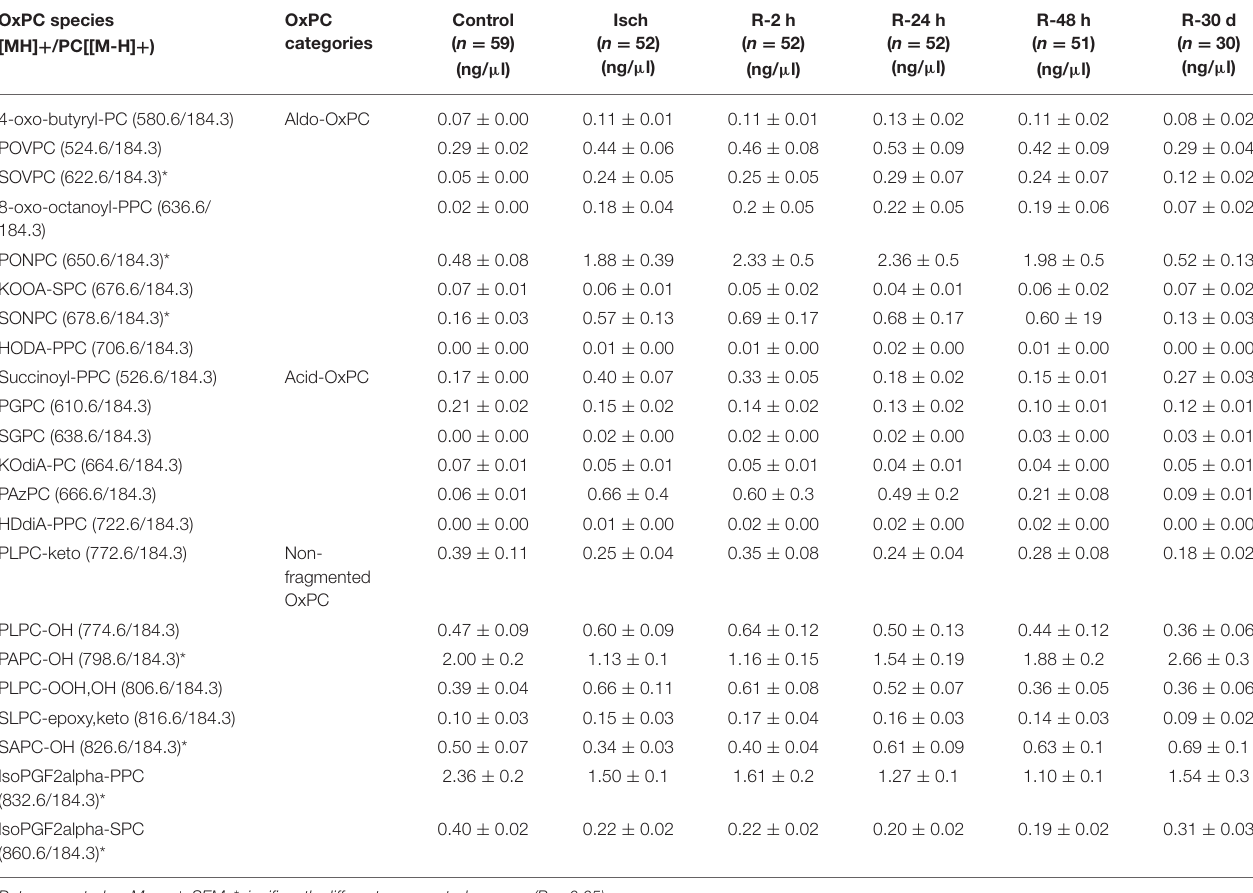
TABLE 2 | Average concentrations of identified OxPCs in study groups. OxPC species